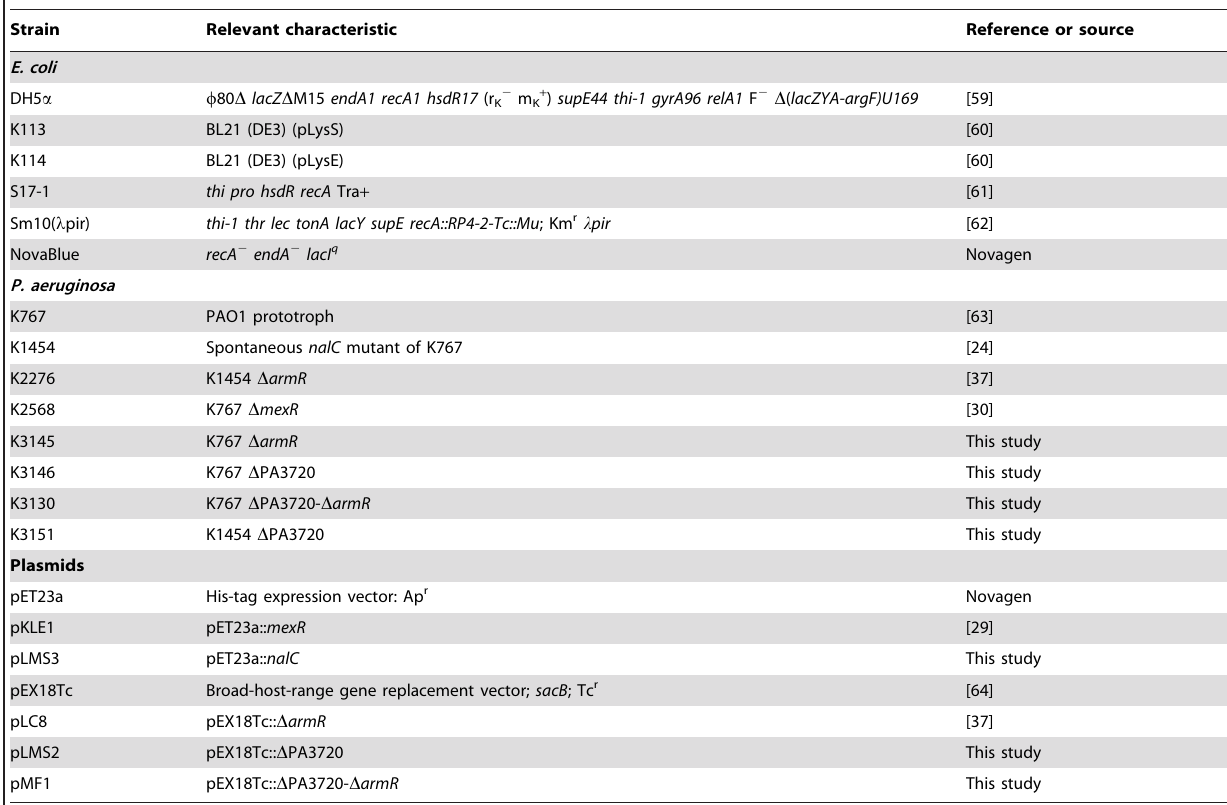
Table 1. Bacterial strains and